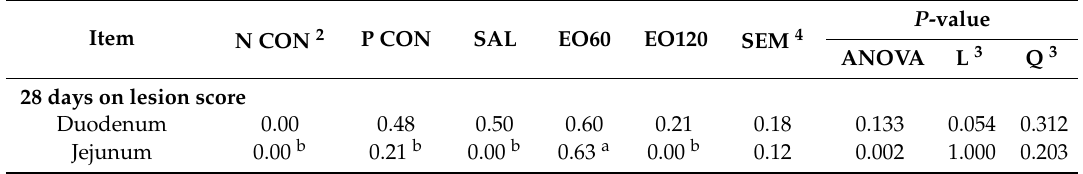
Table4. E ff ectofdietaryencapsulatedessentialoilsongutlesionscoresincoccidiosis-vaccine-challenged broiler chickens